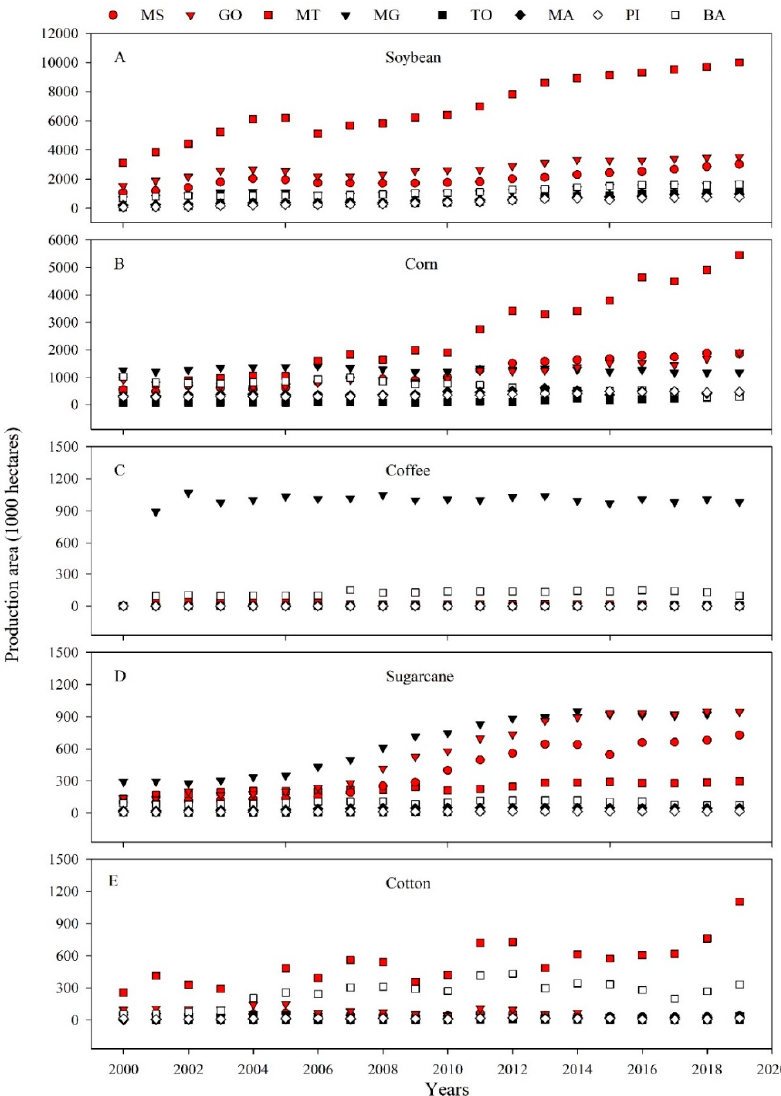
Figure 5. Production area of the Cerrado (1000 hectares) in Minas Gerais (MG), Goiás (GO), Mato Grosso (MT), Tocantins (TO), Maranhão (MA), Bahia (BA), Mato Grosso do Sul (MS), and Piauí (PI) of soybean, corn, coffee, sugarcane, and cotton from 2000 to 2020.